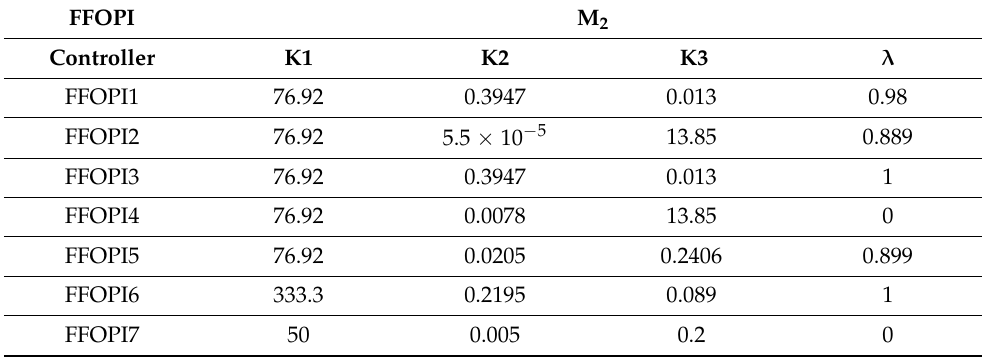
Table 8. FFOPI controller gains of microgrid system M 2 in the case of VIC.